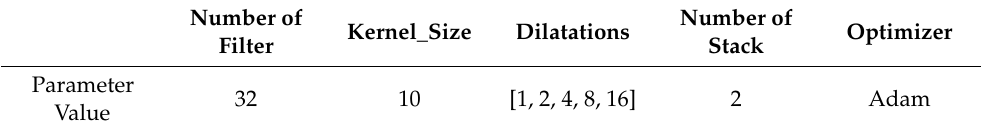
Table 3. Architecture of the proposed TCN model.